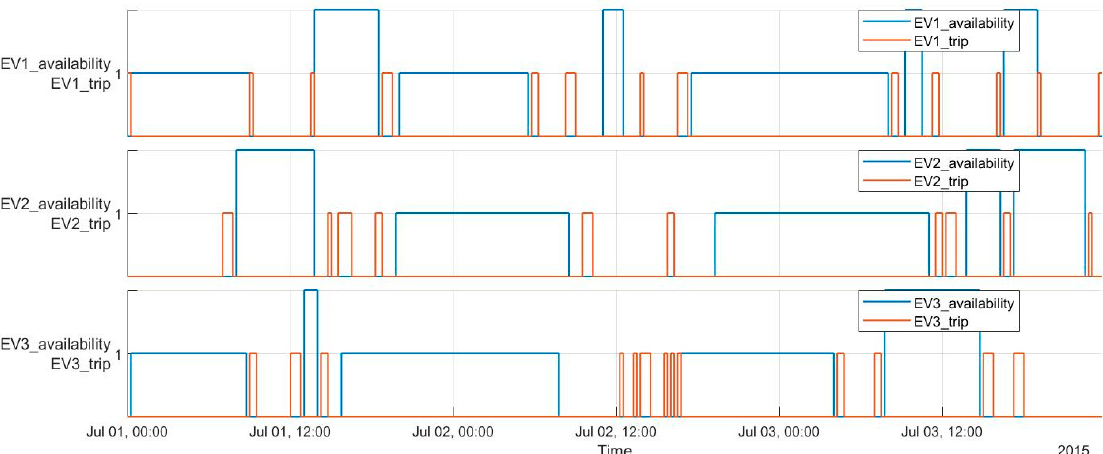
Figure 8. Availability of three selected EVs and their trip time separately. The shortest travel duration is 15 min. For the availability graphs (blue line), one stands for a connection of 3.7 kw, and 2 represents a connection of 7.4 kW.